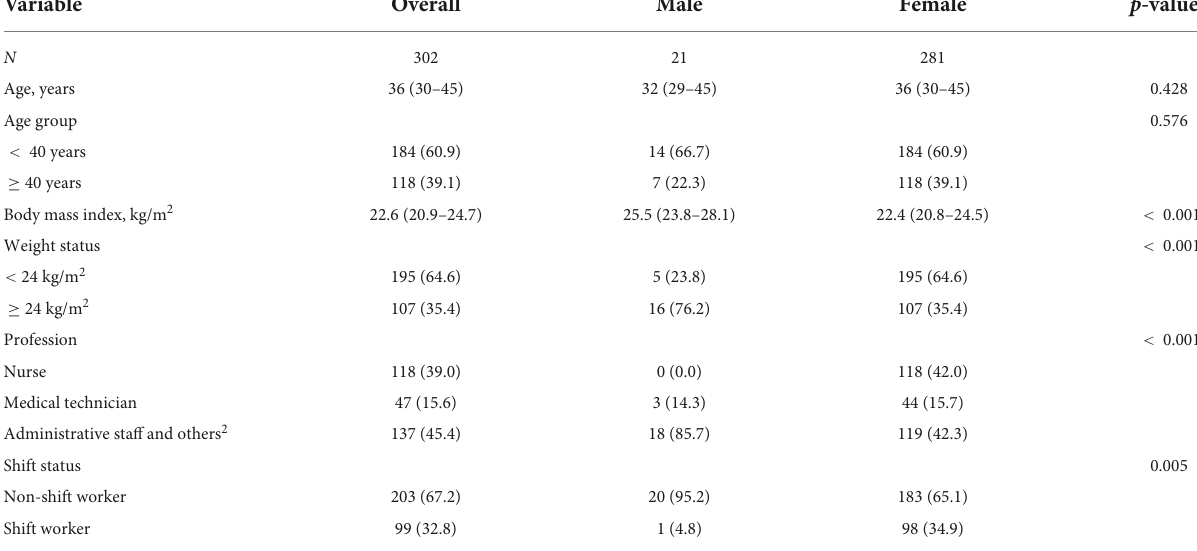
TABLE 1 Characteristics of the study participants.